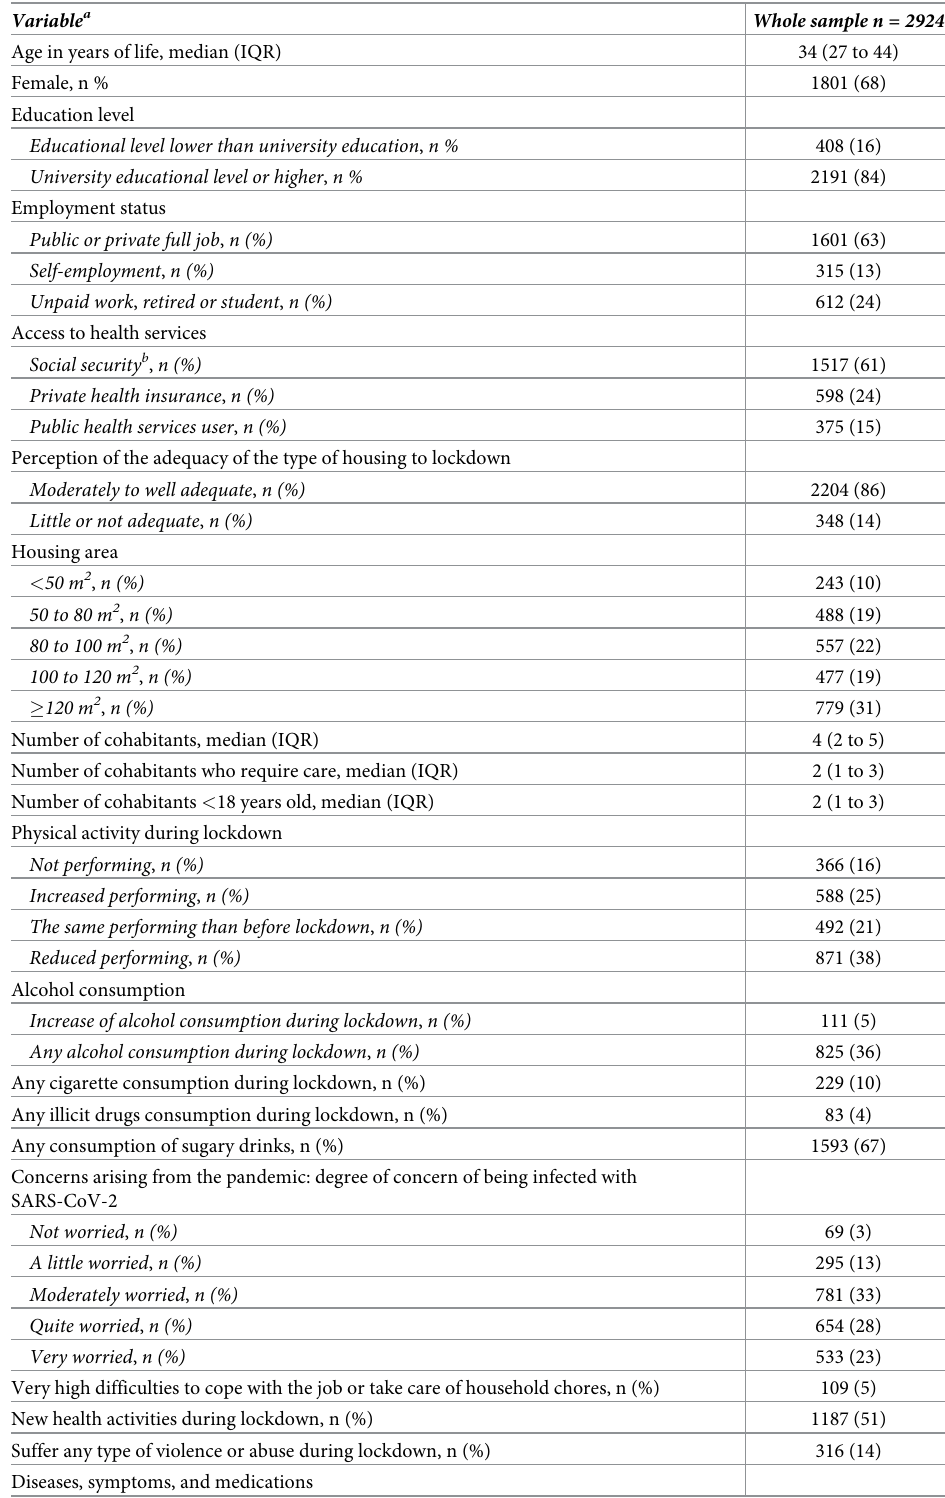
Table 1. Description of the